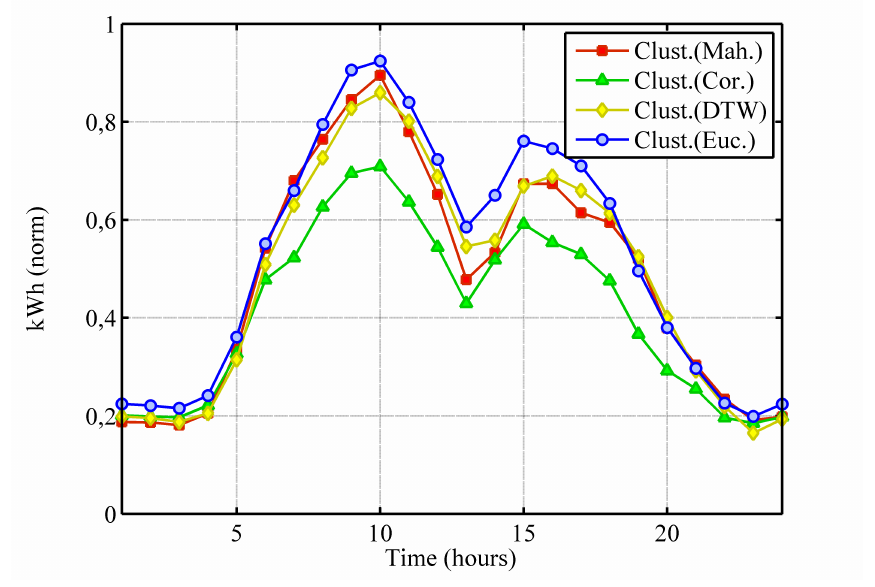
Figure 3. Representative pattern of a specific cluster for building “Edifici A1” according to every clustering solution: using Euclidean (blue circles), Mahalanobis (red squares), based on Pearson’s Correlation (green triangles) and DTW (yellow diamonds) similarity